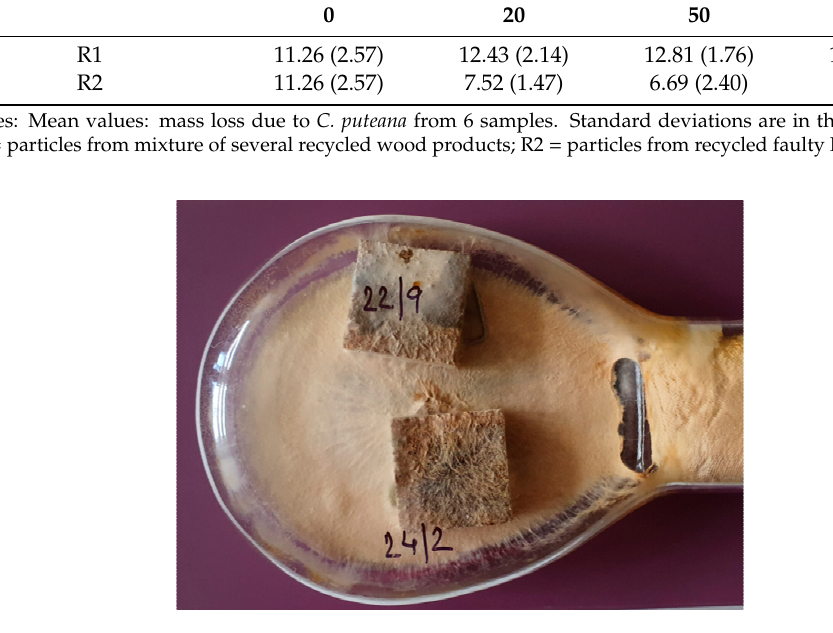
Figure 8. Growth of the surface mycelia of the brown-rot fungus Coniophora puteana on the top surfaces of PB-20-R1 (it contains 20% particles from a mixture of recycled wood products R1 and 80% particles from fresh spruce wood) after 16 weeks of the decay test in Kolle flasks.